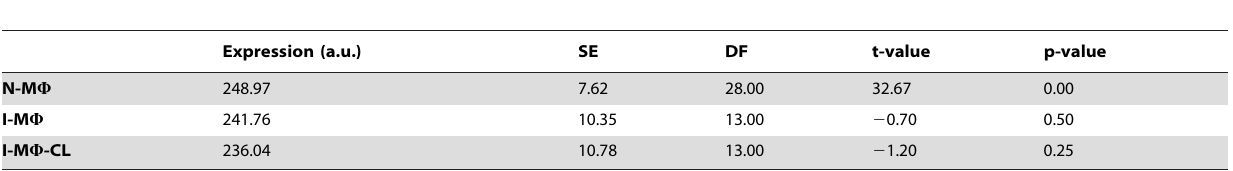
Table 1. Analysis of PLC d 1-GFP expression at the boundary of cells for N-M W , I-M W and I-M W -CL was measured by computational analysis using equation (1.2).